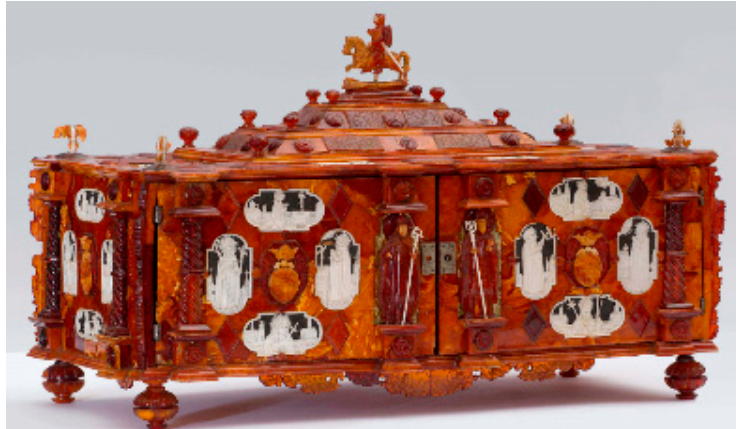
Figure 5. Danzig workshop, Reliquary of St. Kazimierz Jagiello ń czyk, c. 1677–78. Palazzo Pitti (Tesoro dei Granduchi), Florence. Image in the public domain.